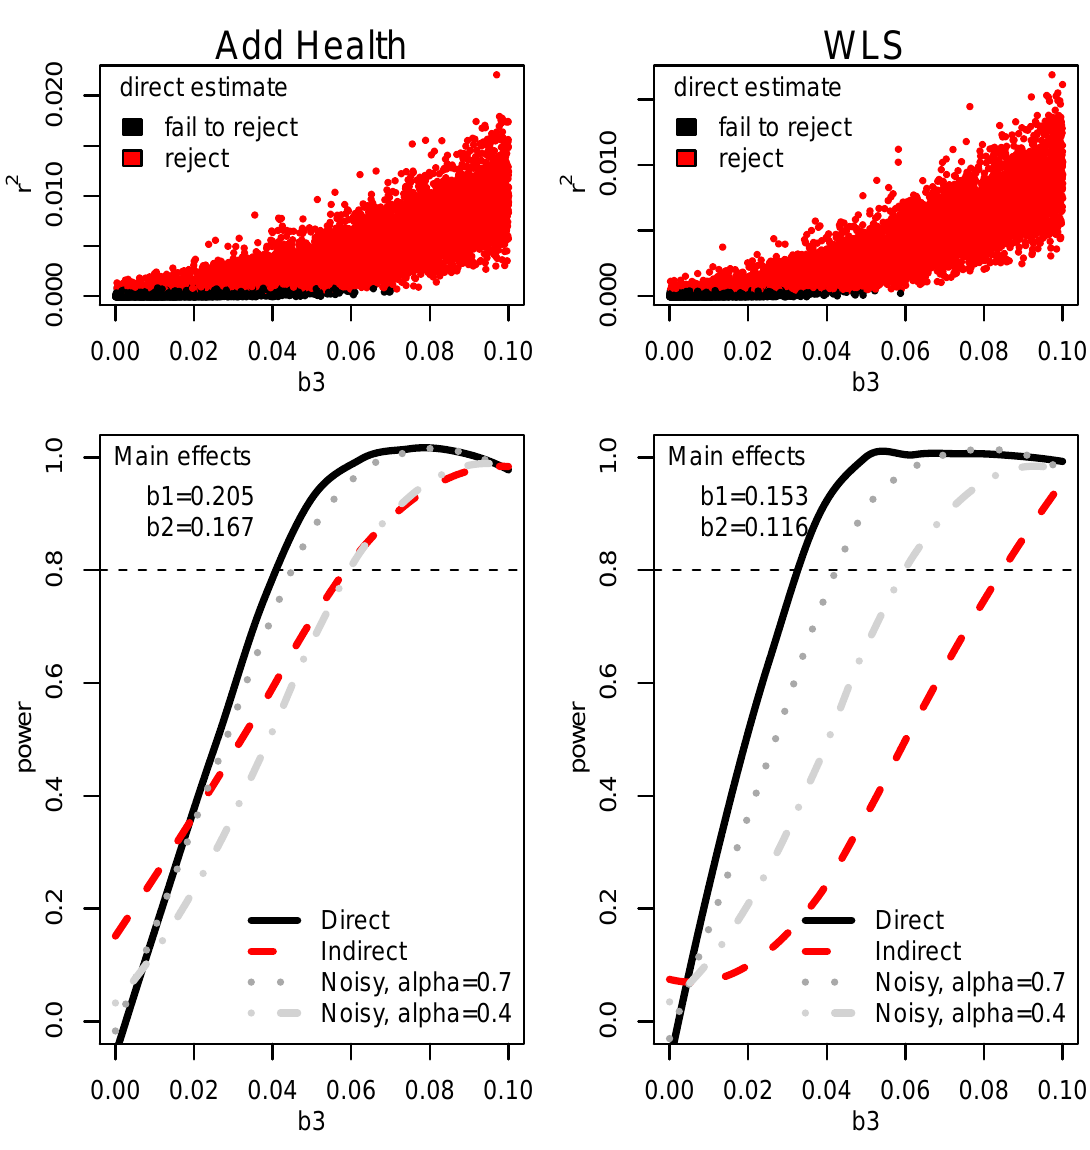
Figure 2: Power analysis based on 10,000 random GxE coefficients (b3; x axis) and specified main effect values (b1 = genetic main effect; b2 = environment main effect). WLS, Wisconsin Longitudinal